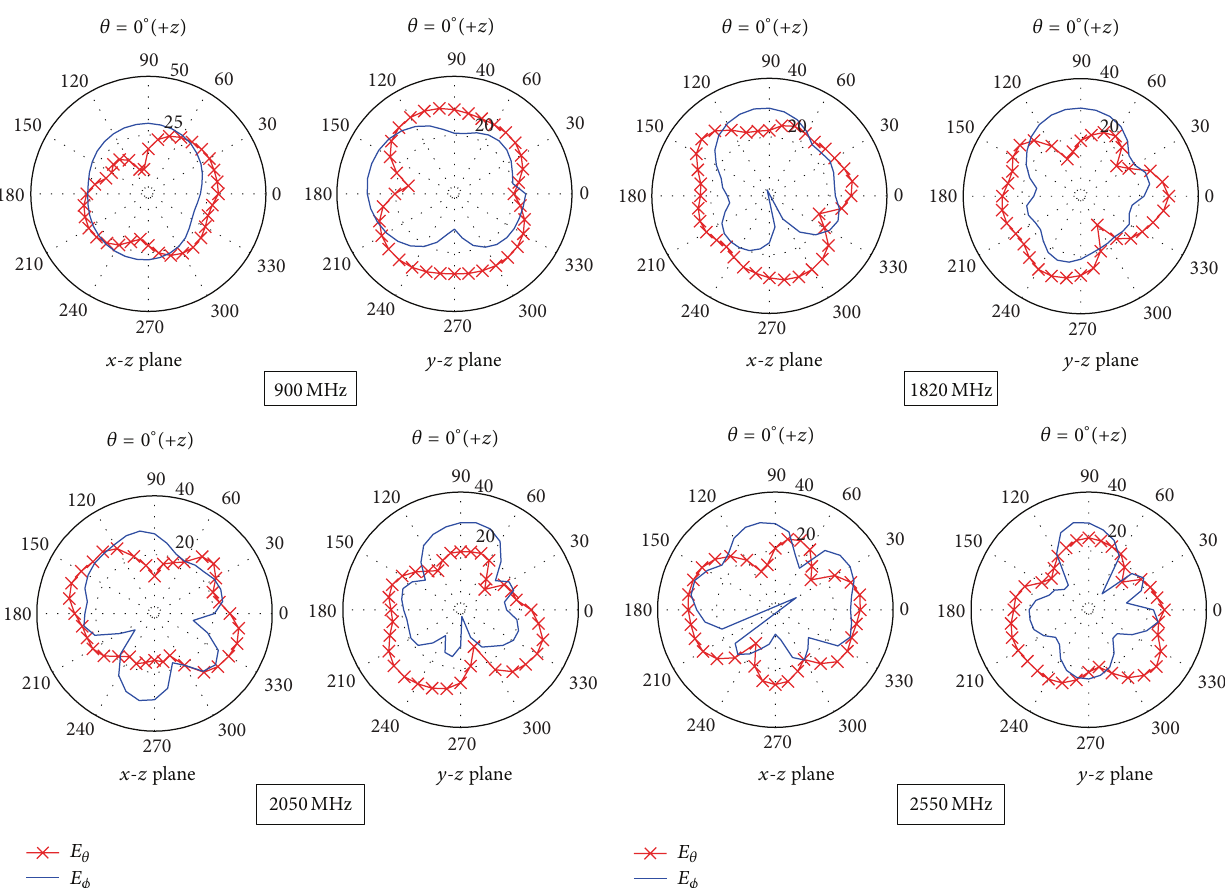
Figure 10: Measured radiation patterns at 900, 1820, 2050, and 2550 MHz of the proposed antenna.